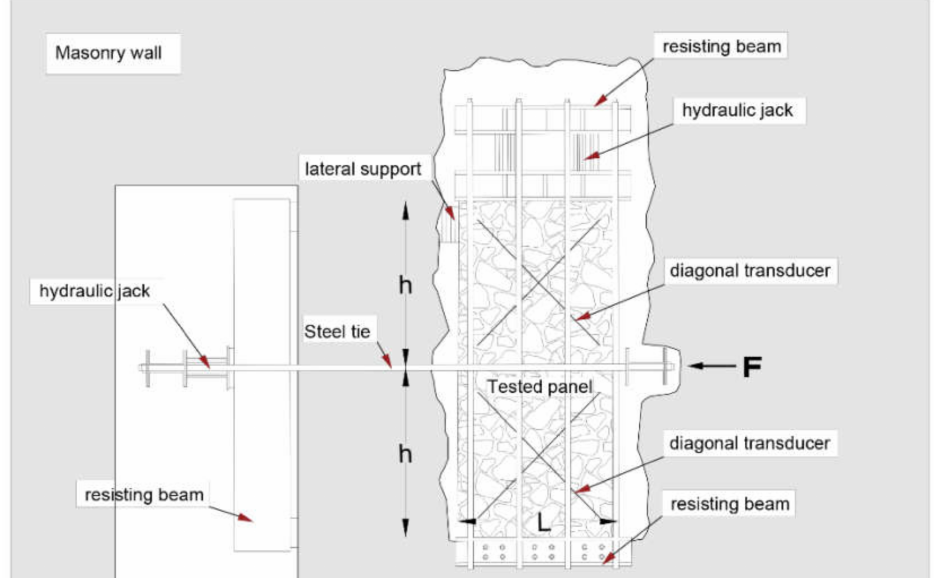
Figure 1. Typical test arrangement for shear compression tests.